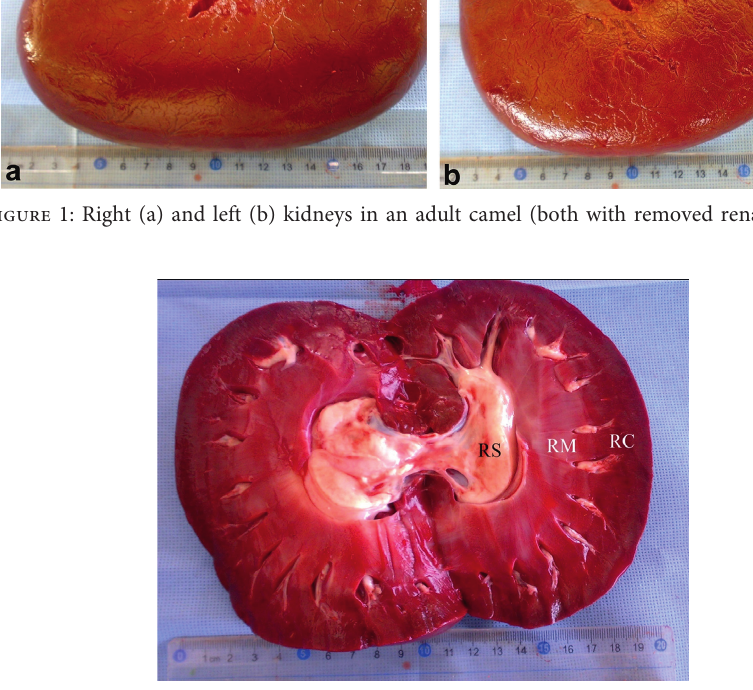
Figure 2: Longitudinal section through the kidney in an adult camel. RC, renal cortex; RM, renal medulla; RS, renal sinus.